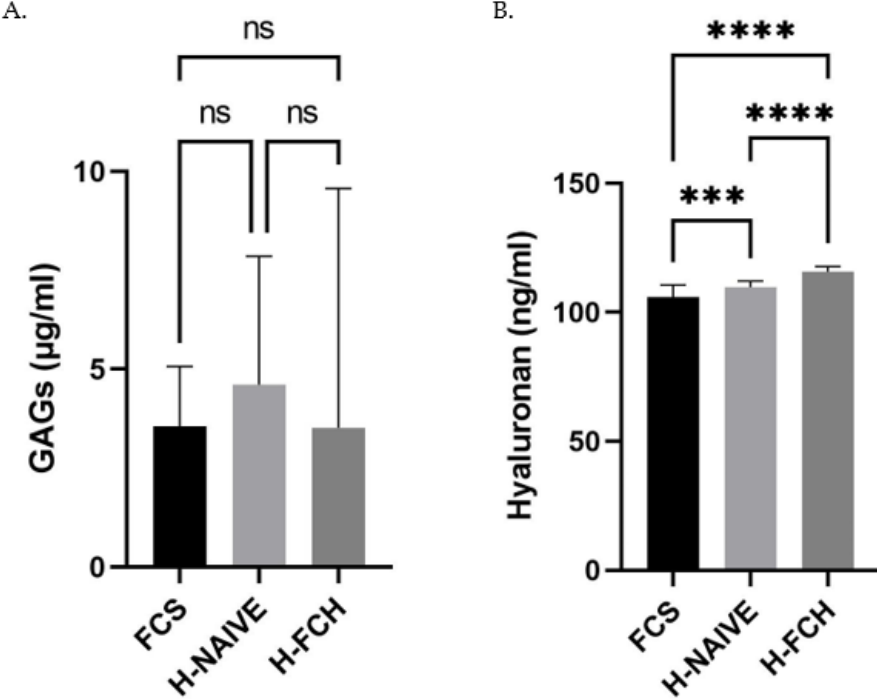
Figure 4. Primary human dermal fibroblasts (adult) were incubated in the presence of either fetal calf serum (FCS) or human naive serum (H-NAIVE) or human serum enriched with metabolites deriving from FCH ingestion (H-FCH). Glycosaminoglycans (GAGs) ( A ) and hyaluronan (HA) ( B ) production. Measures were performed in quadruplicates per condition/volunteer ( n = 10 volunteers). Values are presented as the means ± SD. The differences were considered statistically significant at p < 0.05 with *** for p < 0.001; **** for p < 0.0001 and ns for p > 0.05.